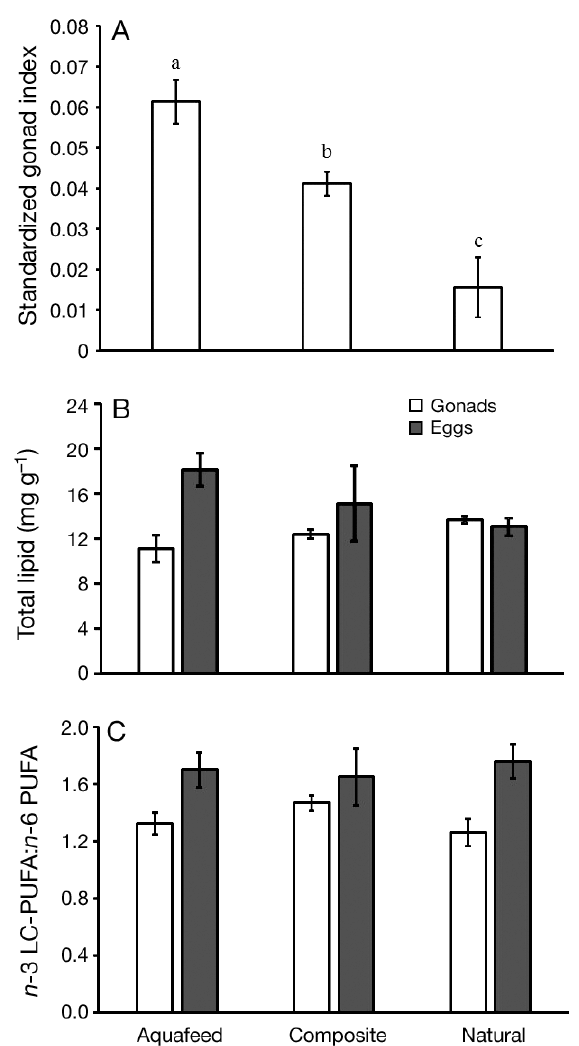
Fig. 3. Mean (±SE) effects of dietary treatment on Graci - lechinus acutus lipid content measured as (A) standardized gonad index, (B) total lipid (mg lipid g −1 dry mass) in gonads and eggs, and (C) n -3 LC-PUFA: n -6 PUFA in gonads and eggs. Superscript letters in (A) denote significant